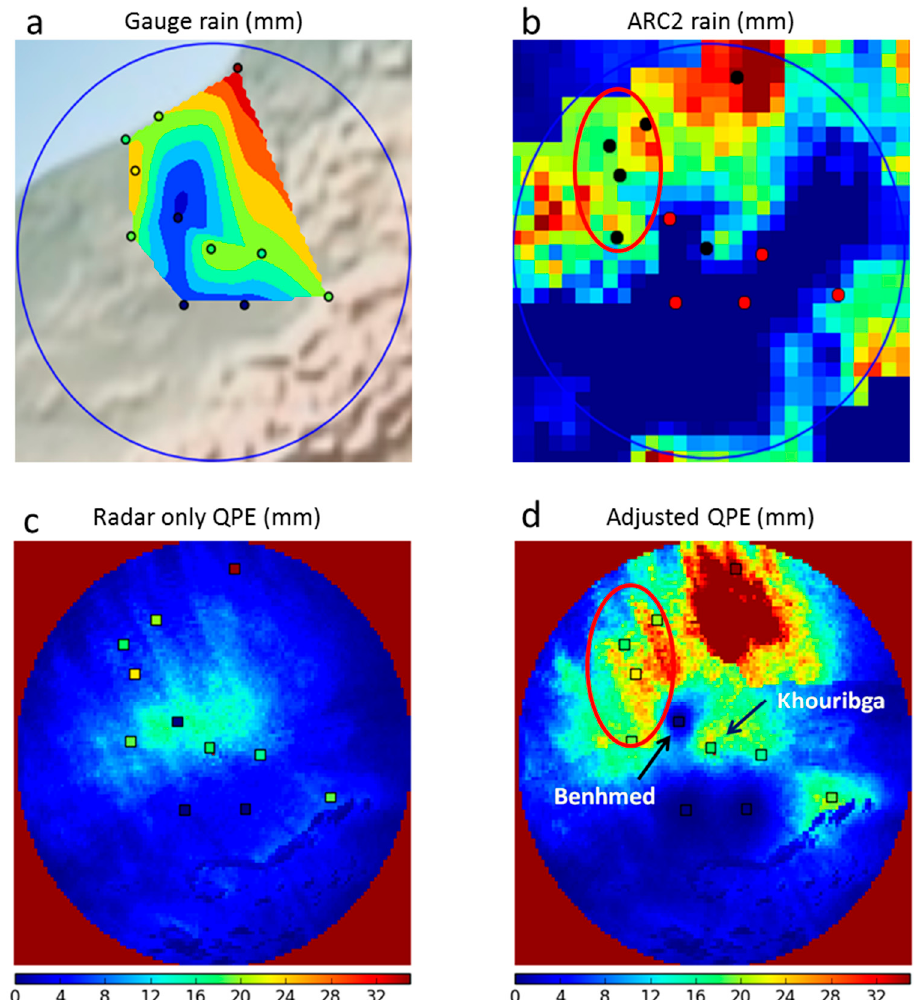
Figure 5. 24 h cumulated precipitations (mm) from December 16, 2016 at 06:00 UTC to December 17, 2016 at 06:00 UTC. ( a ) Interpolation of the rain gauges, and ( b ) African Rainfall Climatology version 2 (ARC2) daily precipitation. The black circles are synoptic stations while the red ones are automatic weather stations. ( c ) Radar-only QPE, and ( d ) adjusted QPE. The squares represent the rain gauges location colored according to the observed precipitation amount.